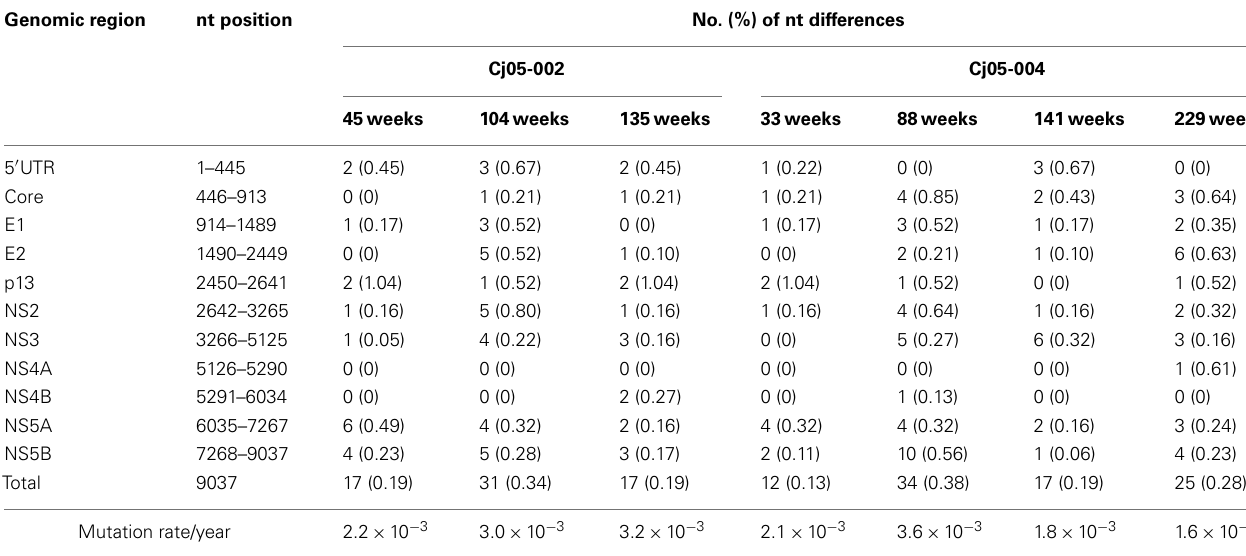
Table 1 | Summary of the nucleotide substitutions in GBV-B genome sequences amplified from plasma of the marmosets persistently infected with GBV-B.